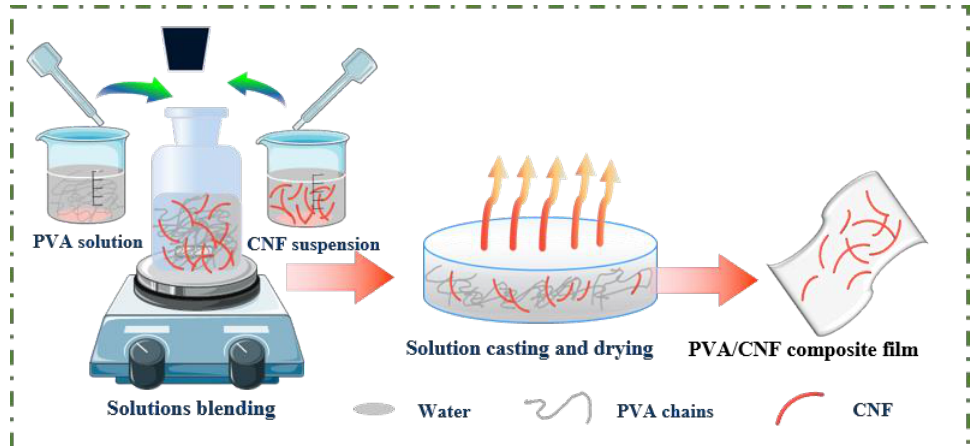
Figure 1. The schematic representation of the synthesis of the PVA/CNF nanocomposite films.